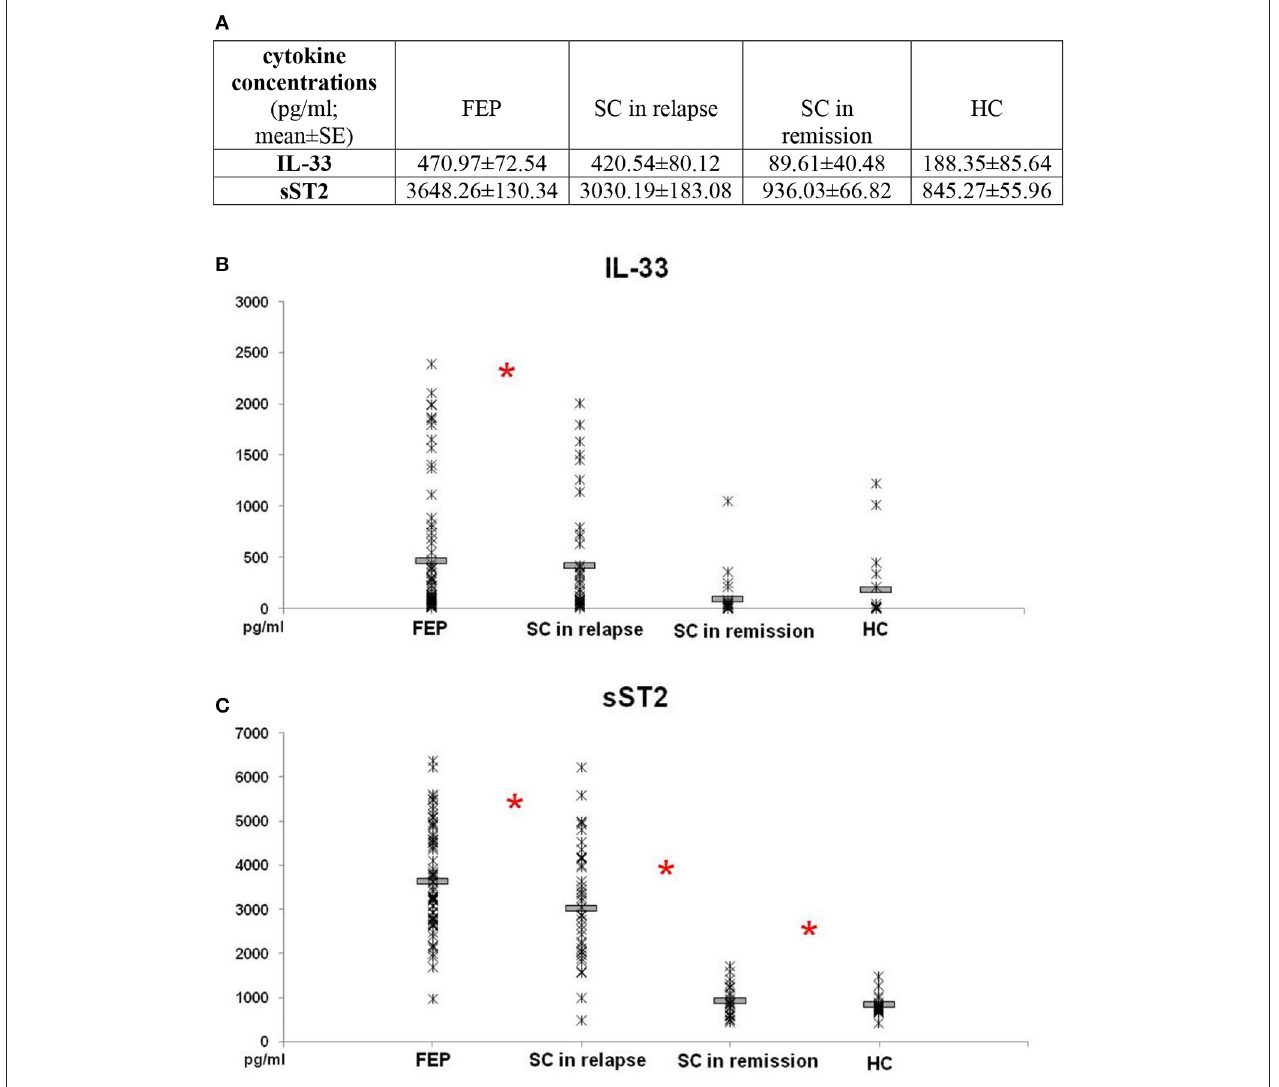
FIGURE 1 | Serum levels of IL-33 and sST2 in FEP patients ( n = 77), SC in relapse ( n = 45), SC in remission ( n = 27) and healthy subjects ( n = 18) were determined by ELISA. Data presented as mean ± SE in Table (A) . Statistical significance was tested by Kruskal-Wallis and Mann-Whitney test (* p < 0.05). Serum concentrations of IL-33 were higher in FEP and SC in relapse, than SC in remission and healthy control subjects ( p ≤ 0.001) (B) . Serum concentrations of sST2 were higher in patients with FEP compared to SC in relapse, than higher values were observed in patients with SC in relapse compared with SC in remission ( p ≤ 0.01) and SC in remission than control subjects (C)